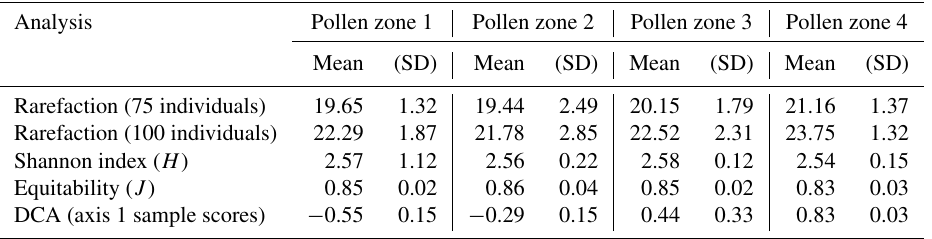
Table 2. Summary of quantitative species diversity and DCA axis 1 sample scores between the late Eocene and early Oligocene from ODP Site